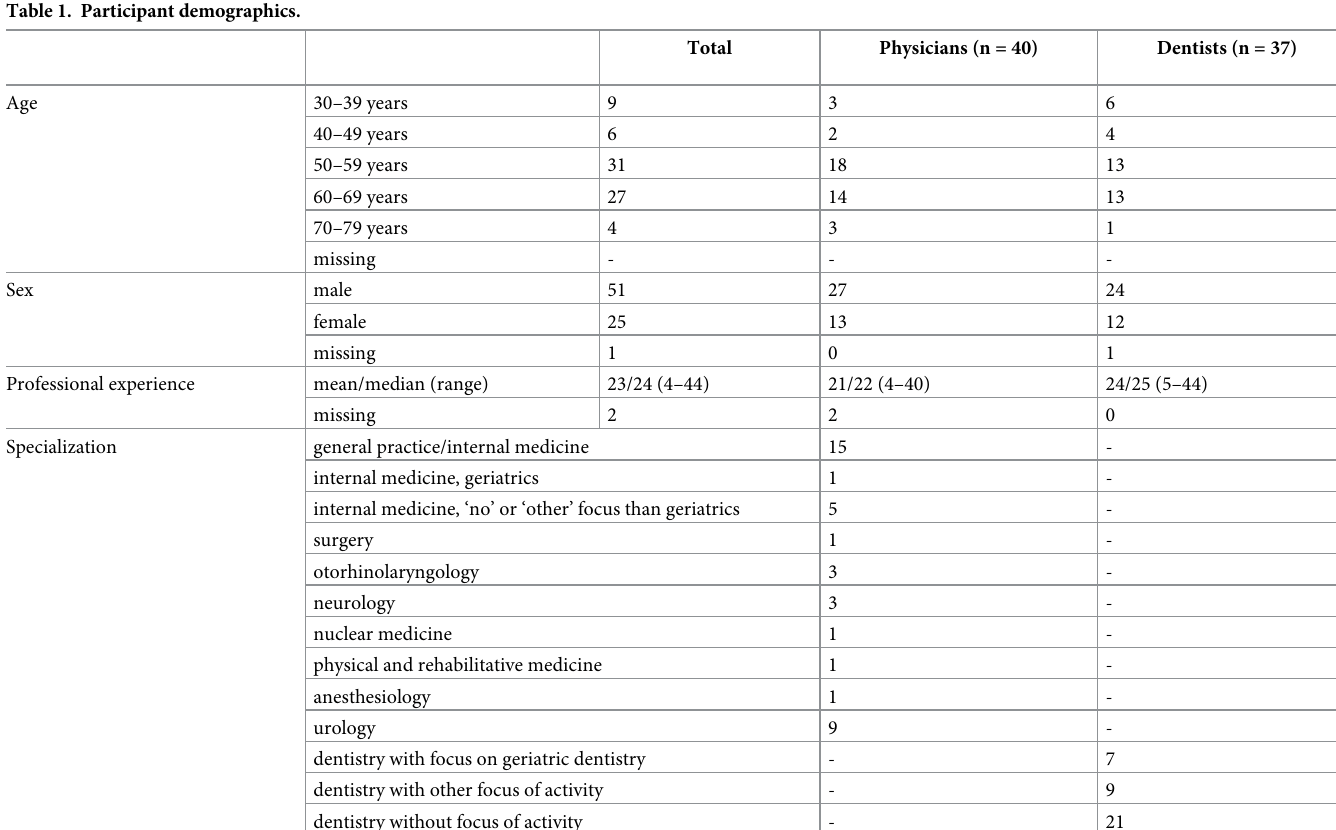
Table 1. Participant